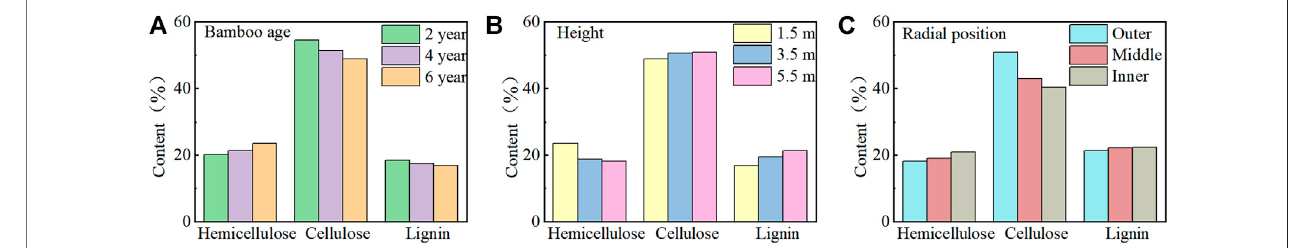
FIGURE 5 | Changes of cellulose, hemicellulose, and lignin contents in bamboo at different ages and locations: (A) Bamboo age; (B) Height; (C) Radial position.